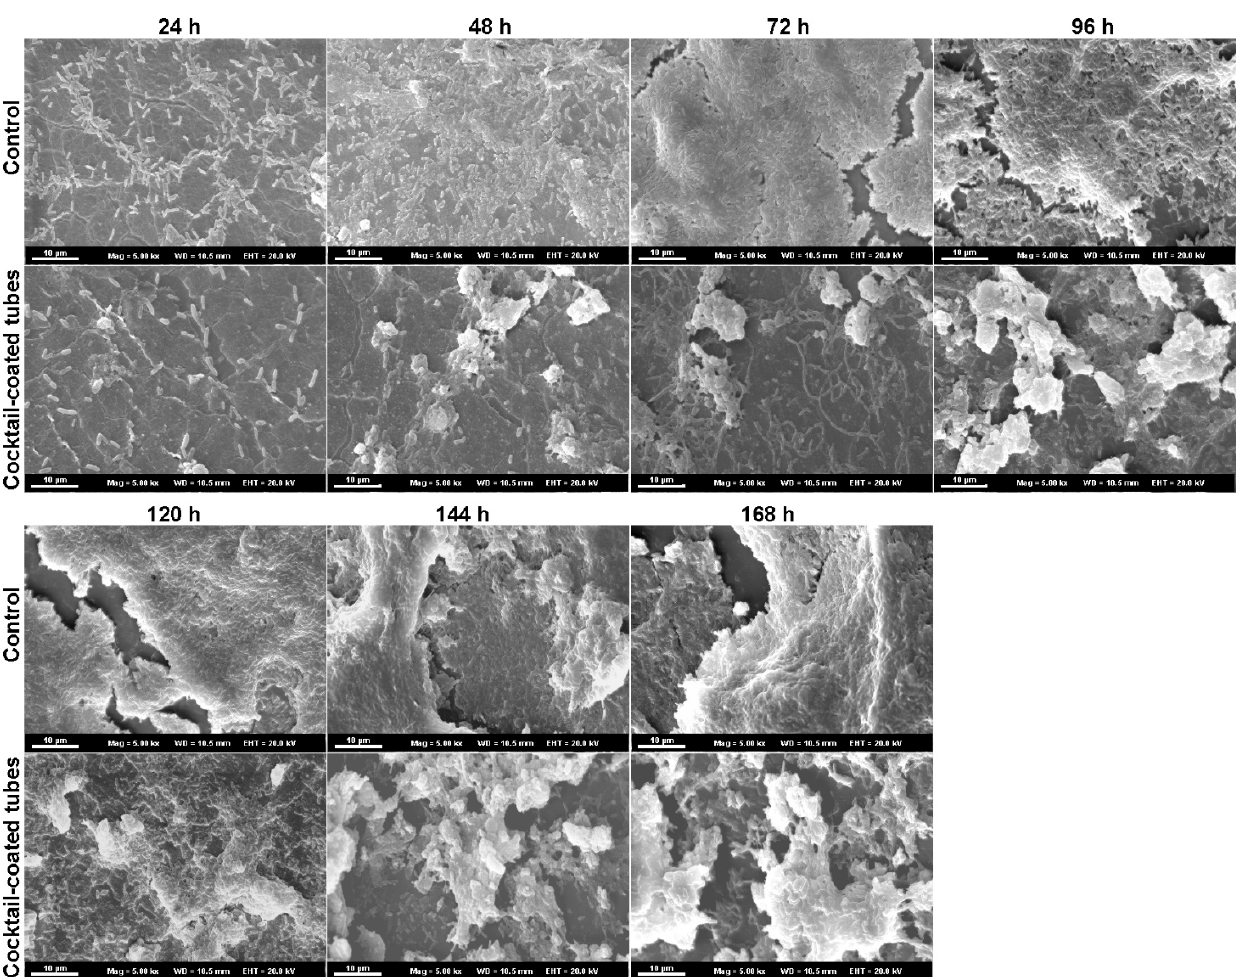
Figure 6. Representative scanning electron micrographs of non-coated (control) and phage cocktail-coated tubes at 24, 48, 72, 96, 120, 144, and 168 h of dynamic biofilm growth. Scale bar = 10 µm.